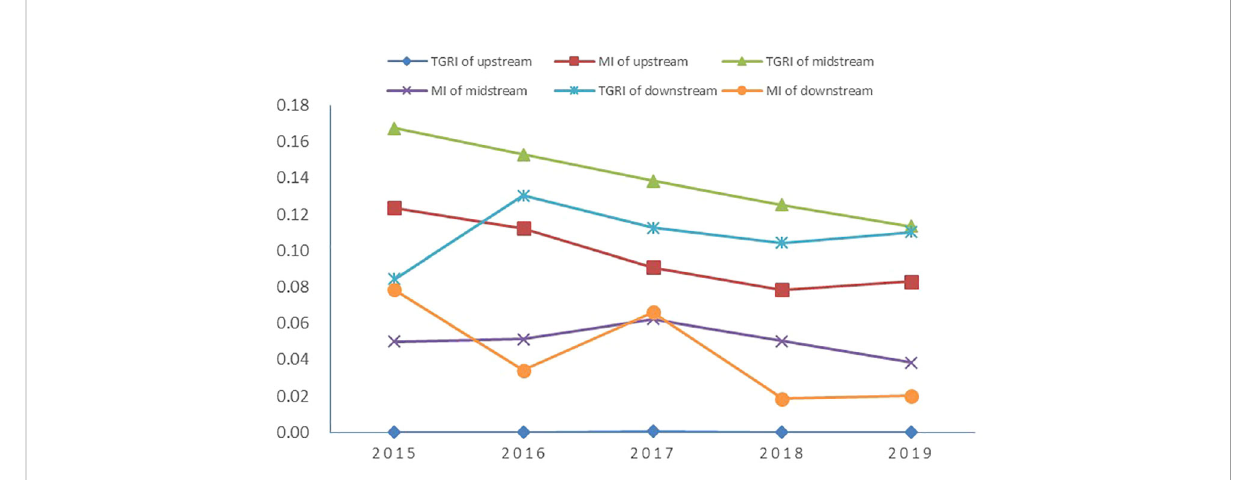
FIGURE 5 Development trends of TGRI and MI in each link of the industrial chain.